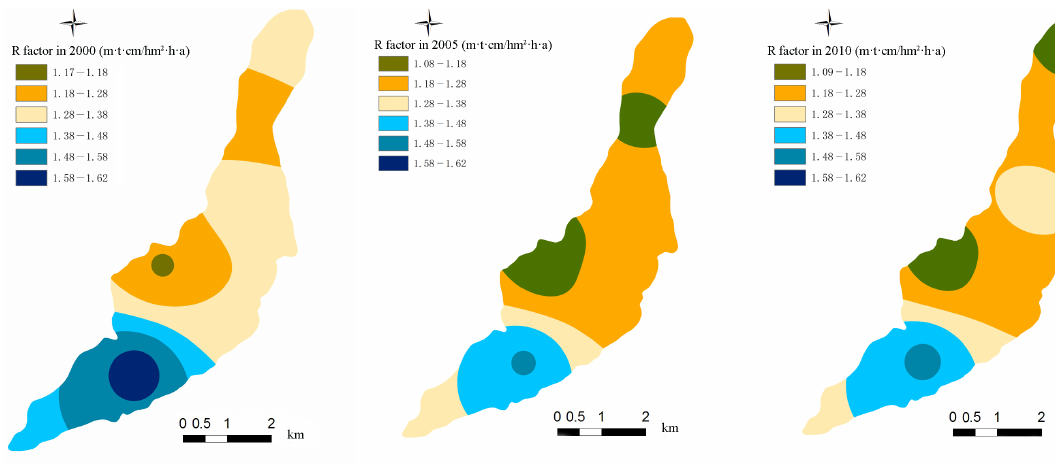
Figure 3. The spatial distribution of rainfall erosivity